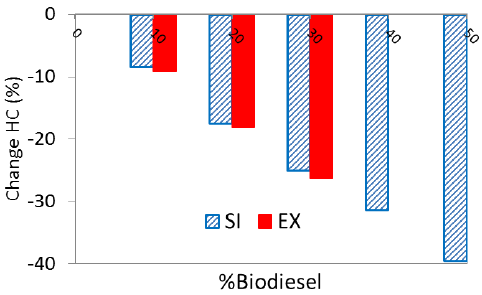
Figure 14. Relationship between HC emissions and biodiesel blending ratio of simulation (SI) and experiment (EX).